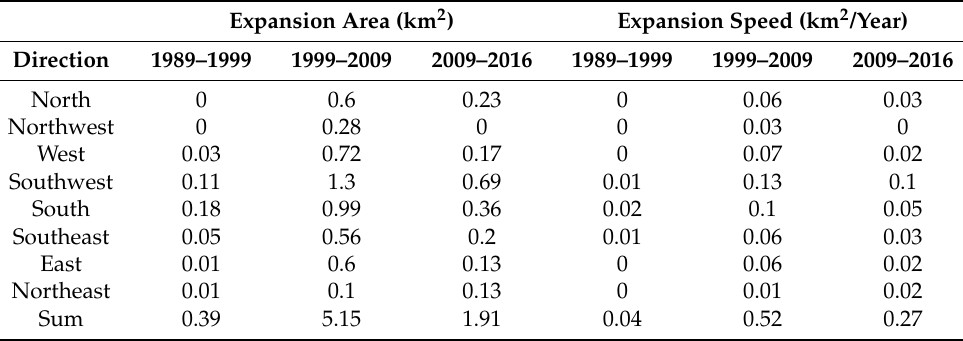
Table 1. Statistic of urban expansion in eight directions from 1989 to